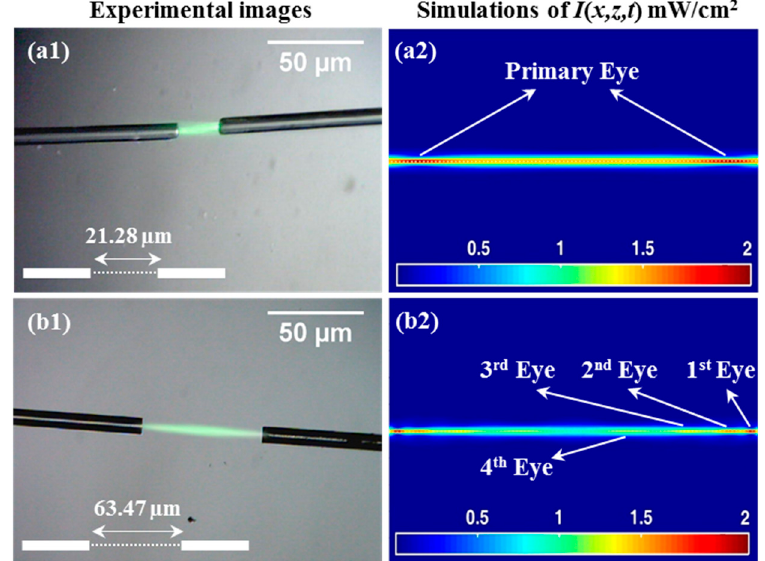
Figure 6. SWW for coupling using counter-propagation beams from single mode optical fibers. t exp = 1600 s of λ = 532 nm and P 0 = 0.1 mW (i.e., each fiber has P 0 = 0.1 mW). The FOCs are aligned and separated by ( a ) 21.28 µm and ( b ) 63.47 µm.